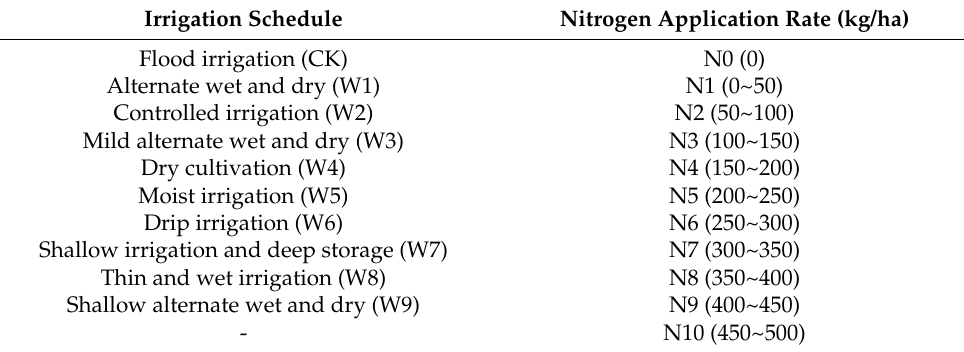
Table 1. Data grouping status.